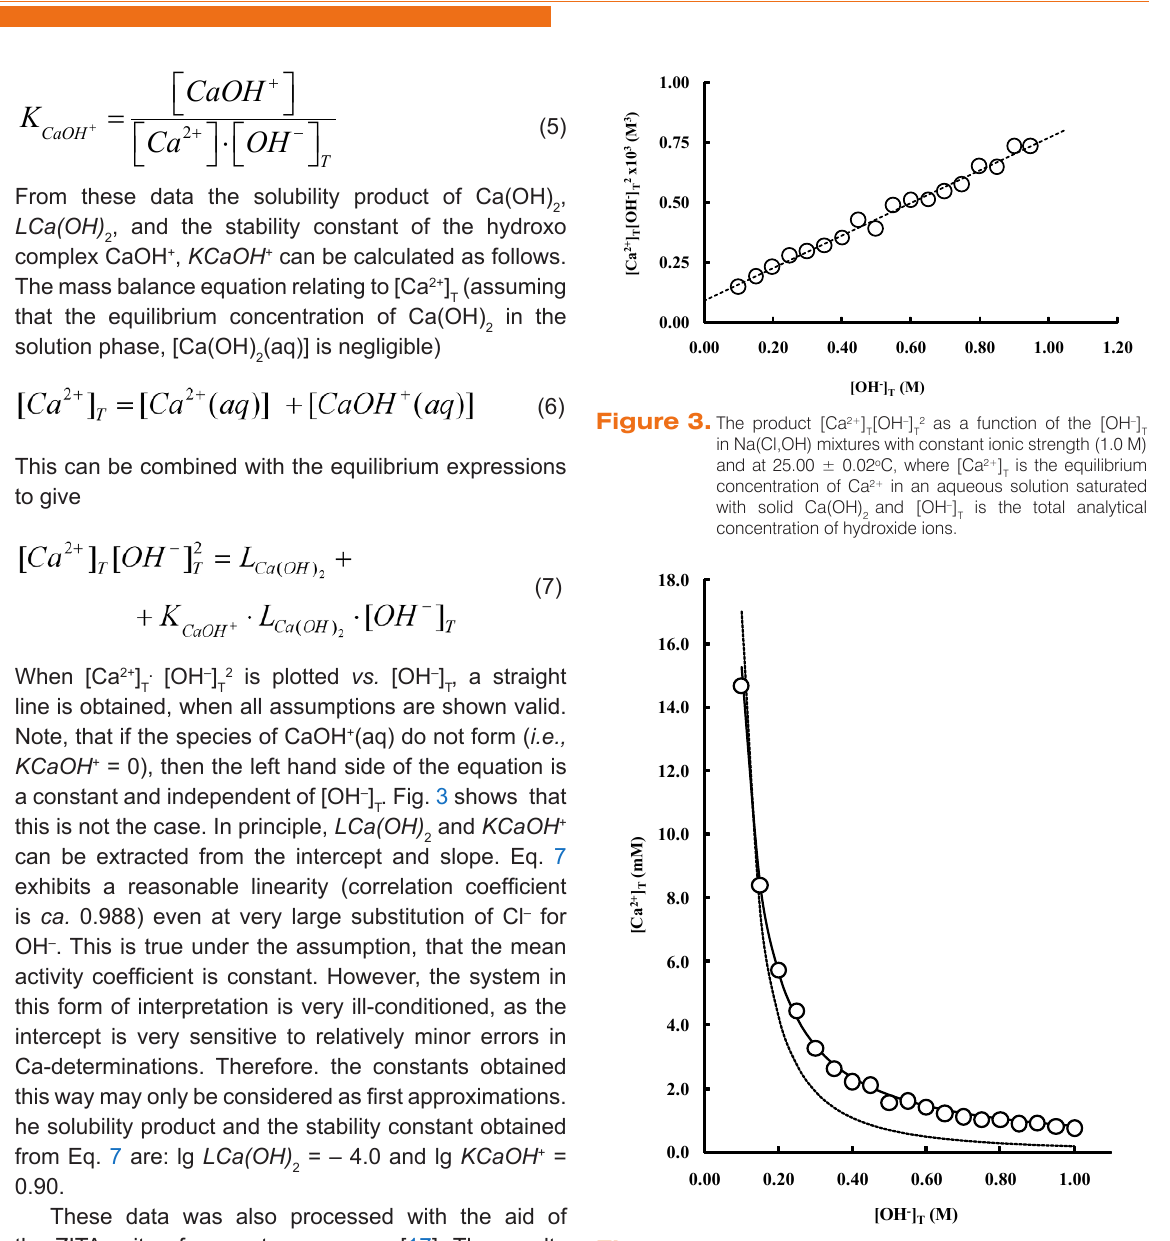
Figure 4. The total concentration of calcium, [Ca 2+ ] in solutions T in equilibrium with Ca(OH) (s) in Na(Cl,OH) mixtures 2 with constant ionic strength (1.0 M) and at 25.00 ± 0.02 o C, as a function of [OH – ] . Circles T represent experimental data. The dotted line was obtained via assuming the presence of Ca 2+ (aq), as the only water soluble calcium species and with an optimized solubility product of LCa(OH) = (1.7 ± 0.1)×10 –4 M 3 . 2 The solid line was calculated via including CaOH + (aq) with KCaOH + = 9.3 ± 0.5 M –1 and with a solubility product of LCa(OH) = (7.9 ± 0.2)×10 –5 M 3 2